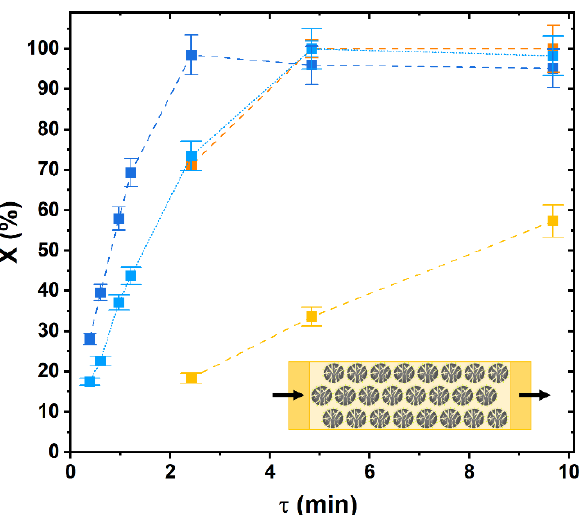
Figure 7. Dependency of the of pNPG conversion with the residence time in fixed ‐ bed reactors containing immobilized enzyme: Ag ‐ Gly 2000 U _pNPG /g support (dark blue) (t reac = 0.63 min), Ag ‐ Gly 200 U_ pNPG /g support (light blue) (t reac = 0.83 min), Ag ‐ PEI 2000 U_ pNPG /g support (orange) (t reac = 0.1 min), Ag ‐ PEI 200 U _pNPG /g support (yellow) (t reac = 0.55 min). Data are mean values from multiple experiments (n> 3) under conditions of steady ‐ state and are shown with the calculated SD. All reactions were performed at 22.2 °C employing as substrate a solution of pNPG 50 mM (sodium citrate buffer 100 mM pH 5.0).